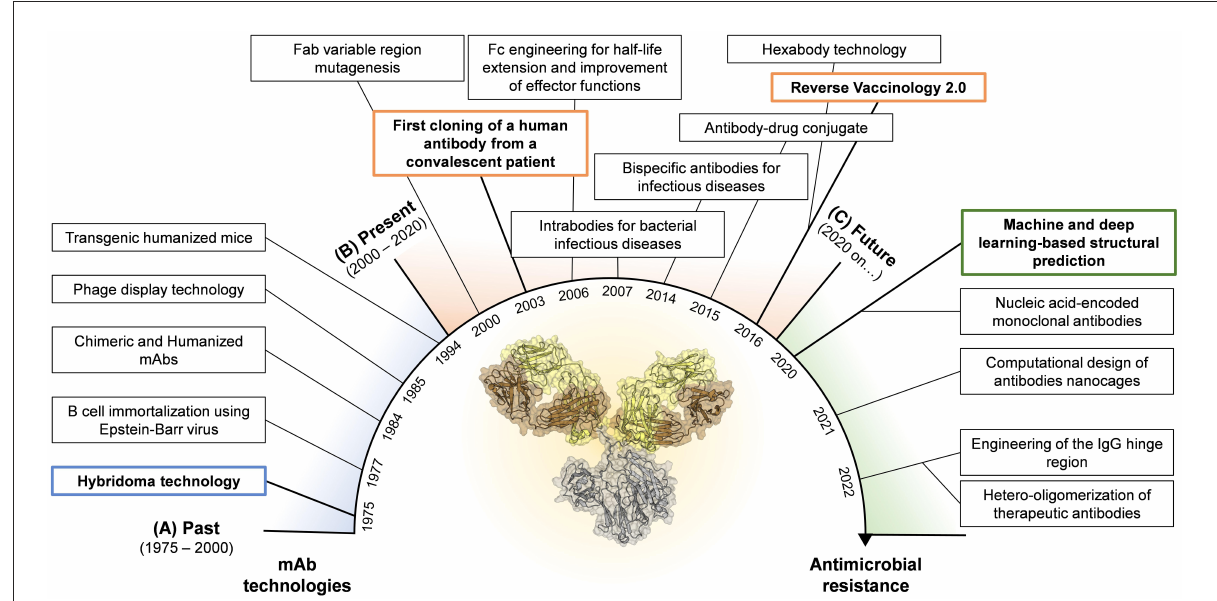
FIGURE1 Timeline for mAb technologies developed in the past (A) and presently used in the field of infectious diseases (B) . Highlight of novel technologies that show great potential and could be applied in the near future in the fight against AMR (C) . Boxes highlighted in blue, orange and green represent the milestones achieved in the past, present, and future,